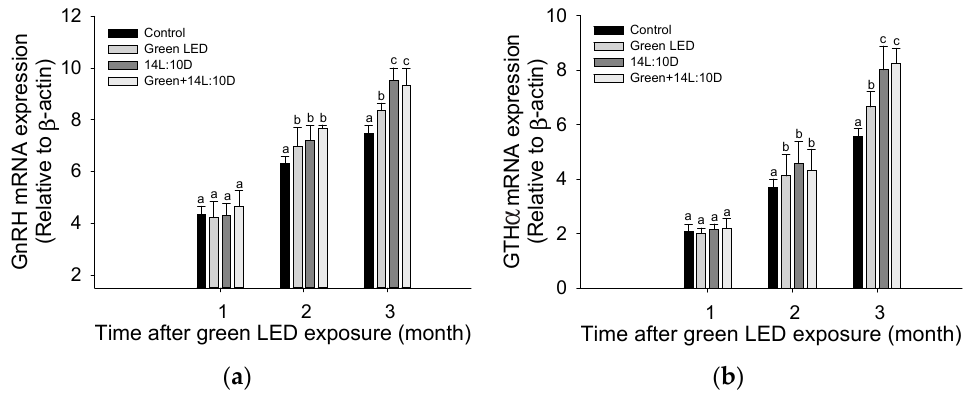
Figure 1. Chub mackerel, Scomber japonicus , were exposed to a 12 h light and 12 h dark photoperiod, either under fluorescent lighting (Control) or under green LEDs (Green LED); mackerel were also exposed to an extended 14 h light and 10 h dark photoperiod under fluorescent lighting (14L:10D) or green LEDs (Green+14L:10D). Total RNA was extracted from the brains of fish (n = 40; full length, 33.7 ± 3.5 cm; weight, 453.5 ± 10.4 g per group) and subjected to quantitative polymerase chain re- action to assess the expression of ( a ) GnRH mRNA and ( b ) GTH α mRNA at onset of the experiment, after 1 month, and after 2 months. Vertical bars denote standard errors. Values with different su- perscripts (a, b, or c) within a given observation period indicate significant differences between groups ( p < 0.05) as determined using Tukey’s multiple range test.